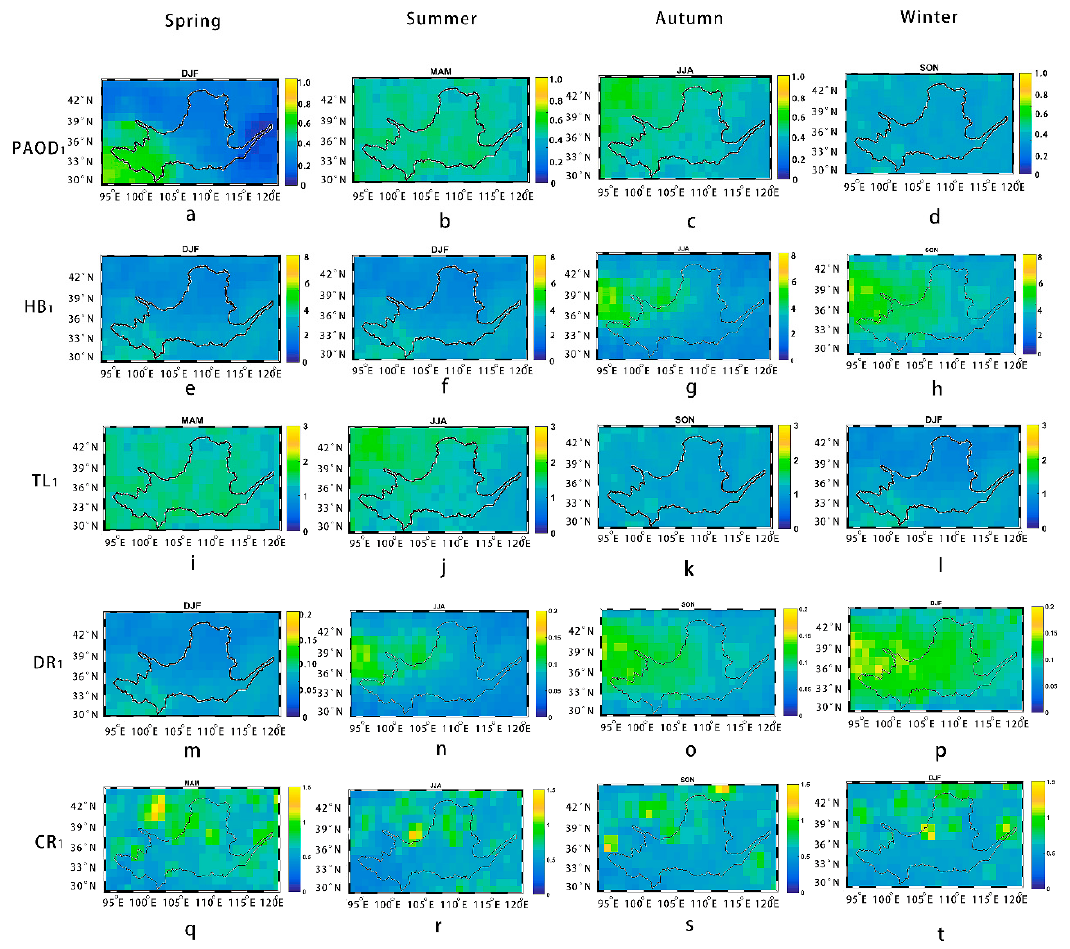
Figure 5. Seasonal distribution of PAOD 1 ( a – d ), HB 1 ( e – h ), TL 1 ( i – l ), DR 1 ( m – p ), and CR 1 ( q – t ) in the YERB.